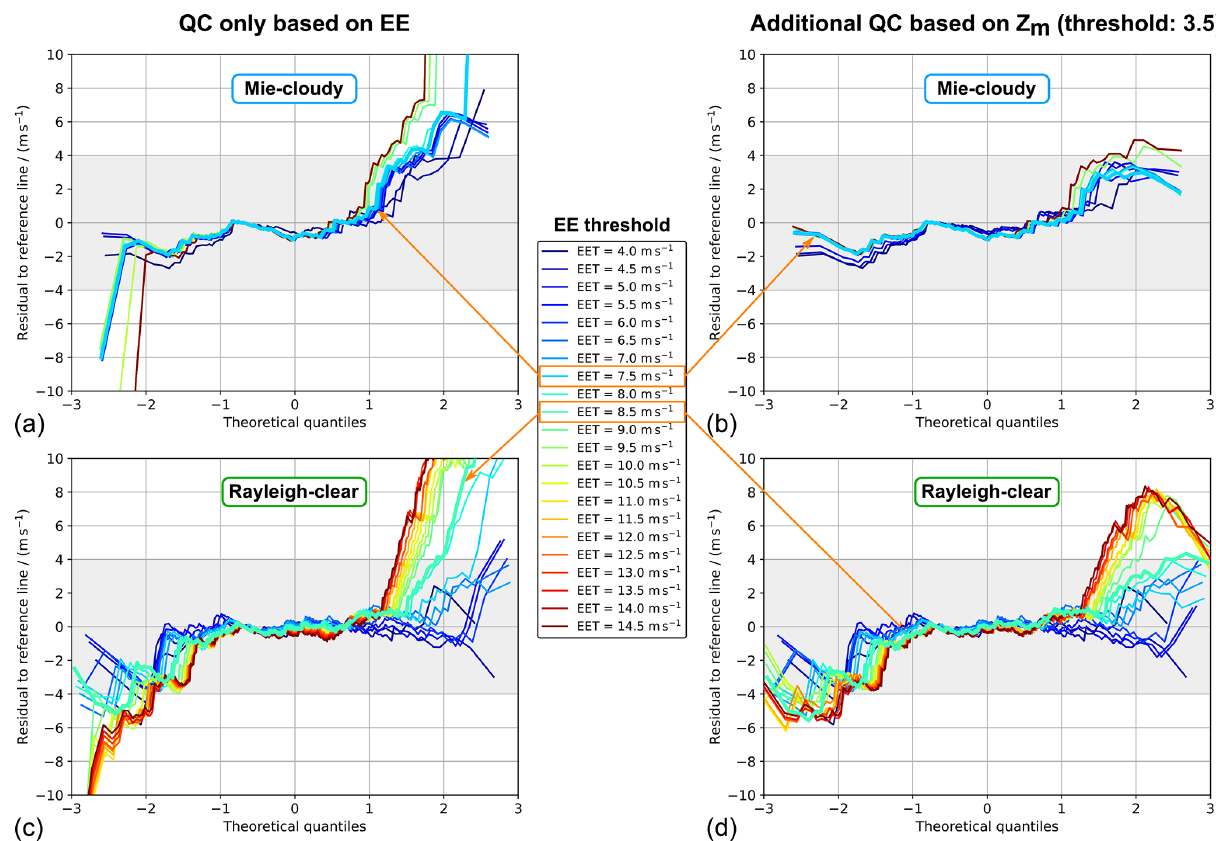
Figure 9. Residual L2B Mie-cloudy (a, b) and Rayleigh-clear wind speed errors (c, d) after subtraction of the quartile reference line from the normal quantile plot based on the comparison to 2µm DWL wind data from the AVATAR-T campaign. The residuals are calculated for different EE thresholds (EETs), as indicated by the colour scale. In panels (a) and (c) , no additional outlier removal was applied, whereas the plots in panels (b) and (d) are obtained after additional QC, based on the modified Z score ( | Z m | > 3 . 5). The curves corresponding to the EE thresholds that are deemed reasonable to provide robust statistical results (Mie is 7.5ms − 1 ; Rayleigh is 8.5ms − 1 ) are plotted by thick